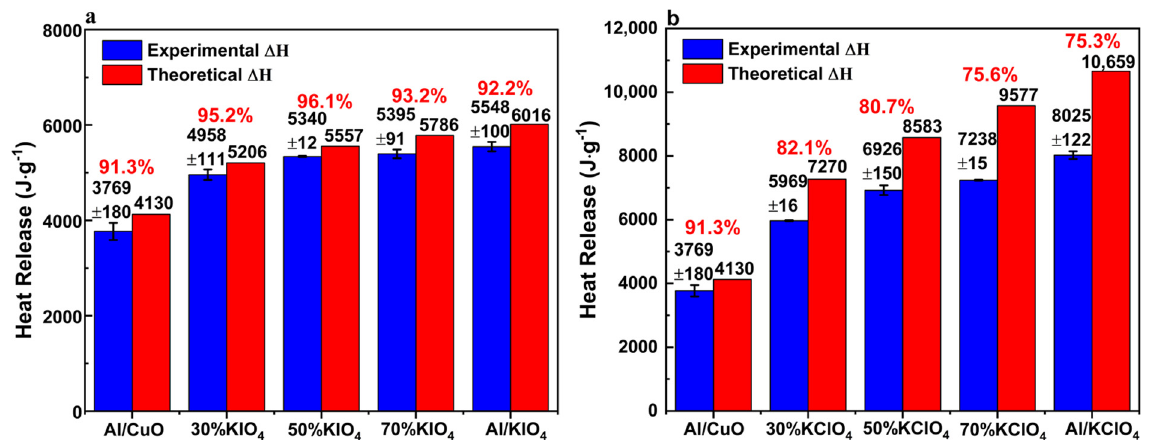
Figure 6. The experimental, theoretical enthalpy, and corresponding combustion efficiency of ( a ) Al/CuO/xKIO 4 and ( b ) Al/CuO/xKClO 4 composites. Note: ‘‘30% KIO 4 ” in Al/CuO/xKIO 4 system means Al/CuO/30%KIO 4 .